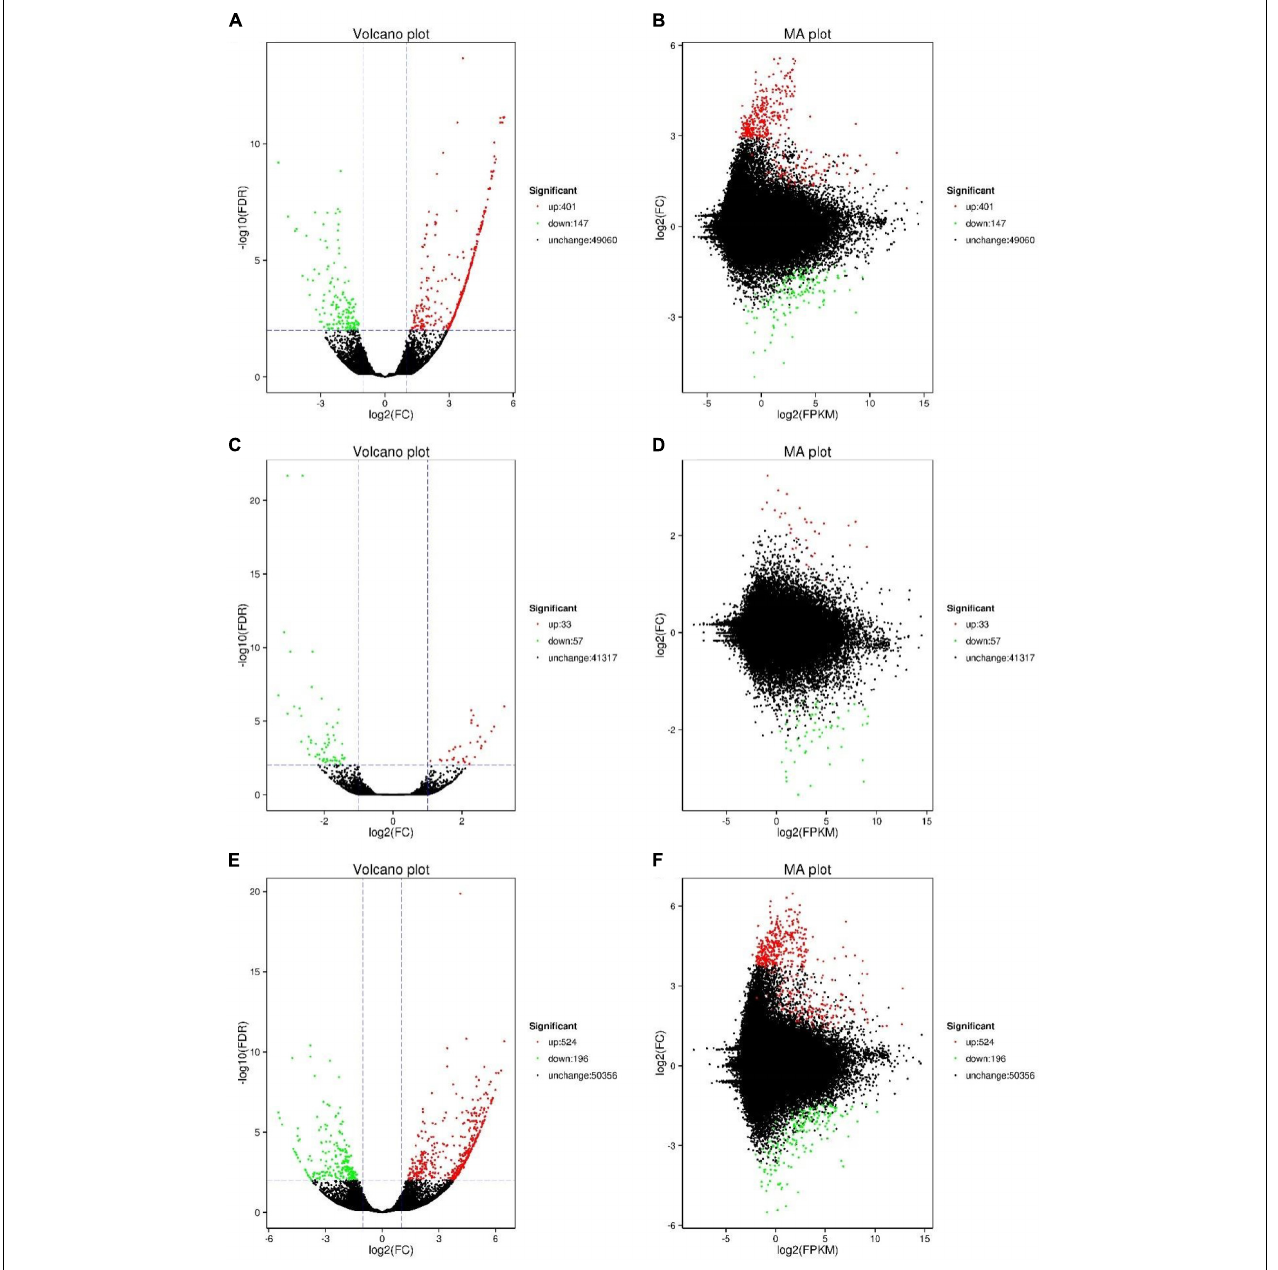
FIGURE 2 | Number of DEGs of C. japonica in three temperature gradients. (A,B) Represent the DEGs between 20 and 28 ◦ C; (C,D) represent the DEGs between 20 and 12 ◦ C; (E,F) represent the DEGs between 12 and 28 ◦